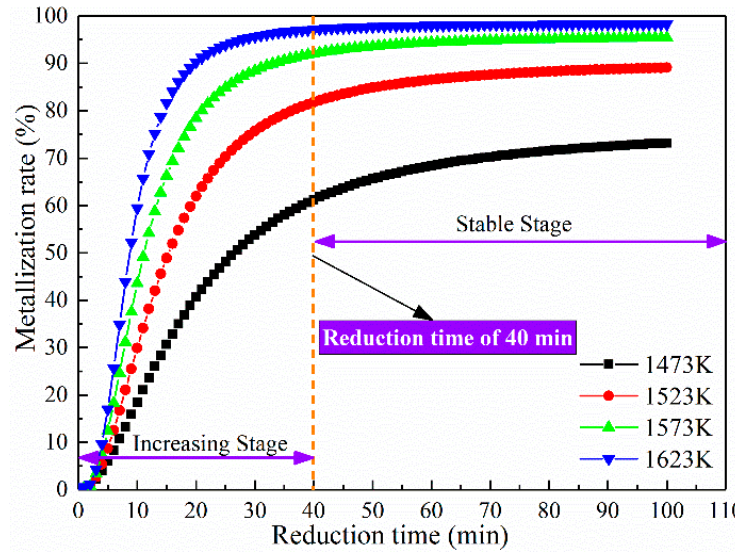
Figure 4. Metallisation rate of coal-based reduction samples.